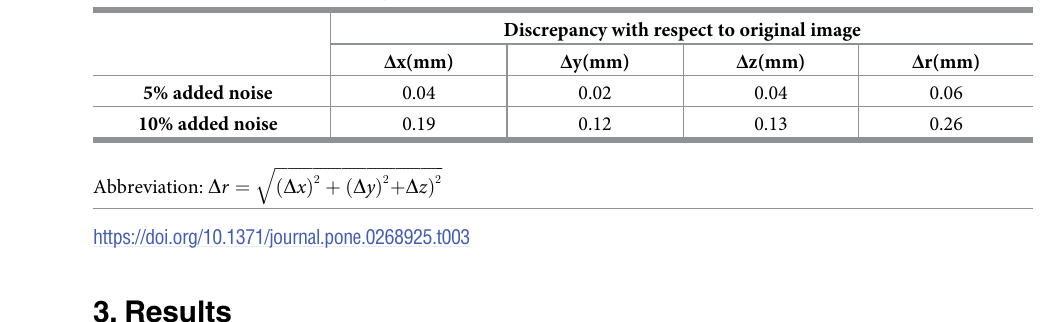
Table 3. Sensitivity of the control point localization algorithm with respect to added noise in the images. Maxi- mum discrepancies on each axis are given. The MRI DICOM coordinate system is adopted.